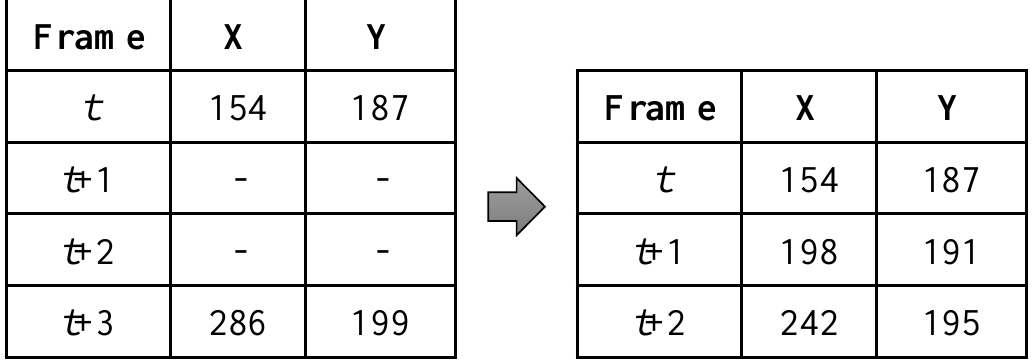
Figure 4. Estimation of finger area when no label remains.